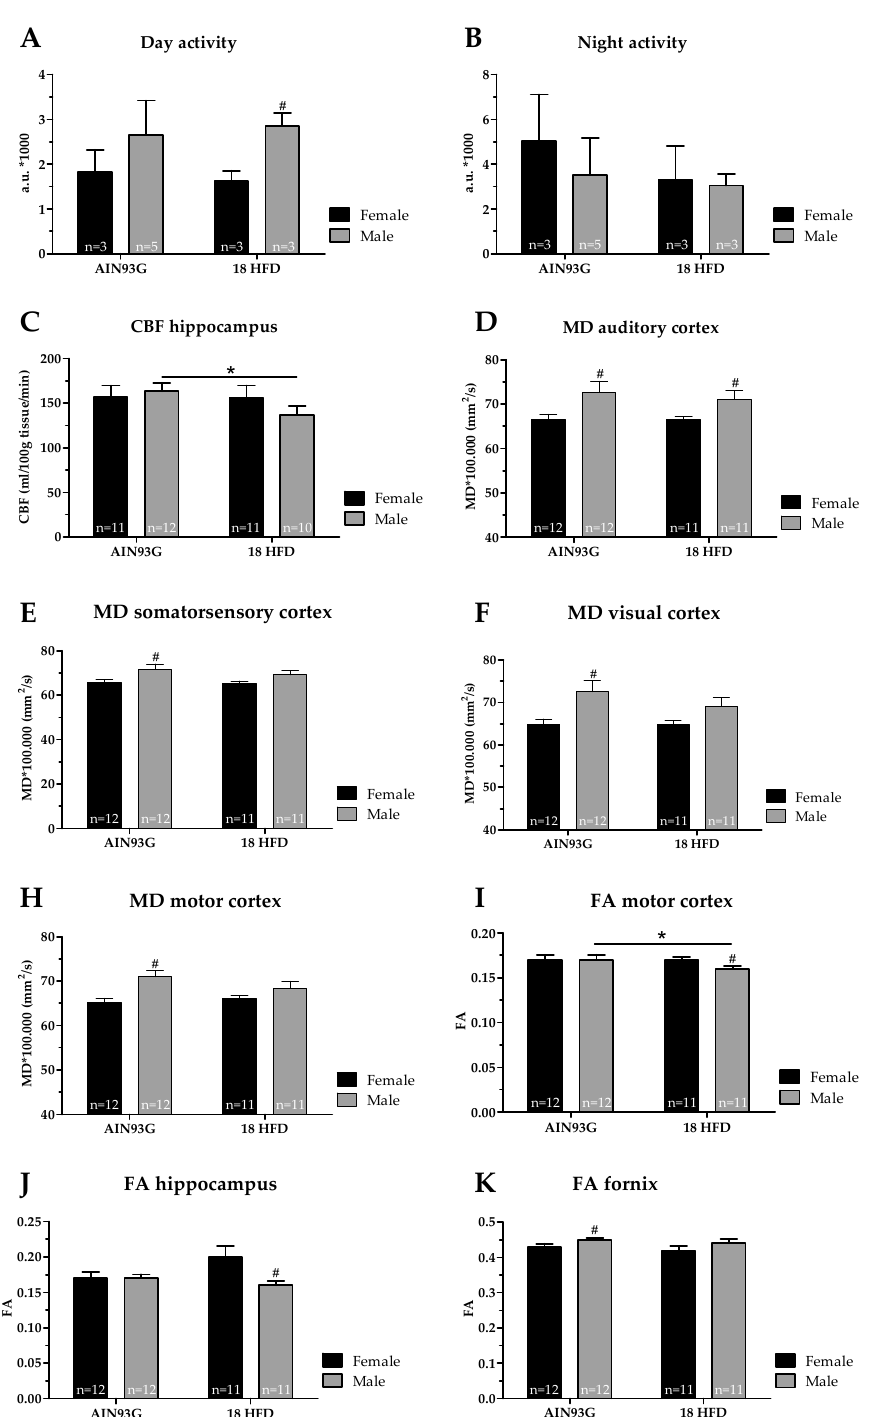
Figure 7. Activity and brain structure in Ldlr-/-.Leiden mice after 18 weeks of AIN93G diet or HFD. Day activity ( A ) and night activity ( B ) were indicated by activation of 12 cage-sensors and expressed in arbitrary units (a.u.) per mouse at cage level. ( C ) Cerebral blood flow (CBF) within the hippocampus. Mean diffusivity (MD) levels within the ( D ) auditory cortex, ( E ) somatosensory cortex, ( F ) visual cortex, and ( H ) motor cortex. Higher MD levels are associated with a decreased gray matter integrity. Fractional anisotropy (FA) levels within the ( I ) motor cortex, ( J ) hippocampus and ( K ) fornix. Lower FA levels are associated with a decreased white matter integrity. * p ≤ 0.050 significant dietary effect (HFD versus AIN93G), # p ≤ 0.050 significant sex-specific. Due to imaging artifacts, one female mice on AIN93G diet and two male mice on HFD were excluded in the CBF analysis, and one male mice fed HFD was excluded in the DTI analysis.